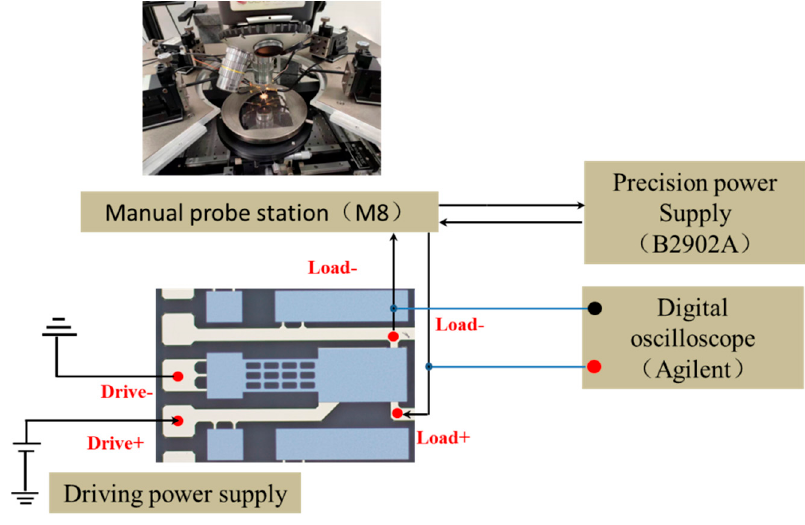
Figure 13. The setup schematic for measuring the contact resistance .